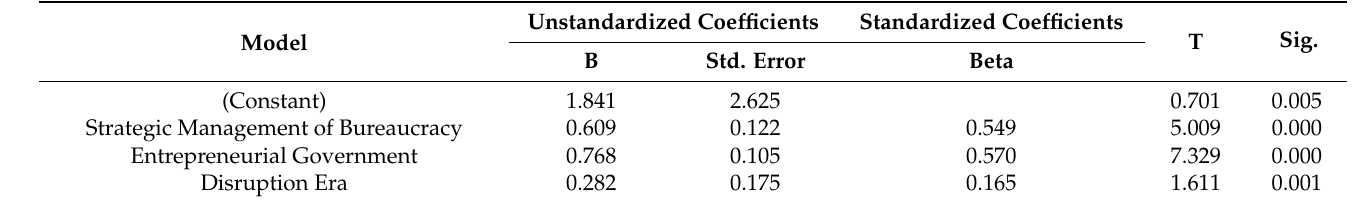
Table 3. Statistics Beta Value Experiment (Standardized Coefficients), Dependent Variables: Industry 4.0 and Society